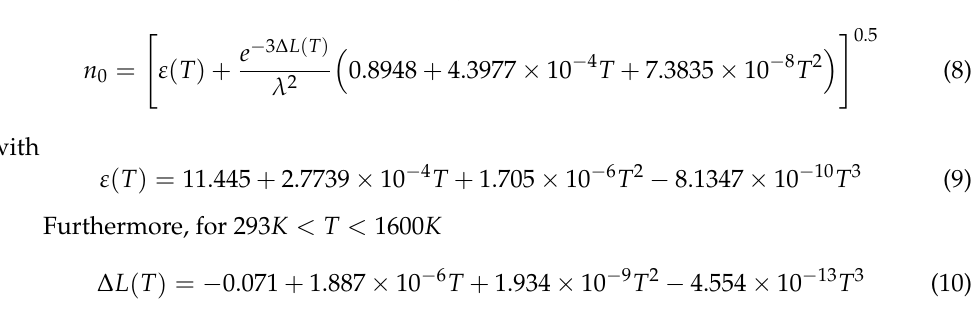
Figure 2. Schematic of the multilayer system. E + is the electricity vector of the reflected